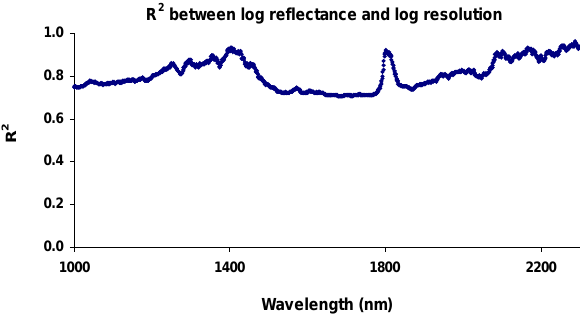
Fig. 5 – R 2 between log reflectance and log resolution between 1000-2300 nm, Fig. 5. R 2 between log reflectance and log resolution between obtained on August 12, 2007, in site 106 (n = 5, significance level < 0.05, and critical 1000–2300nm, obtained on 12 August 2007, in site 106 ( n = 5, value R 2 > 0.65). significance level < 0 . 05, and critical value R 2 > 0 .